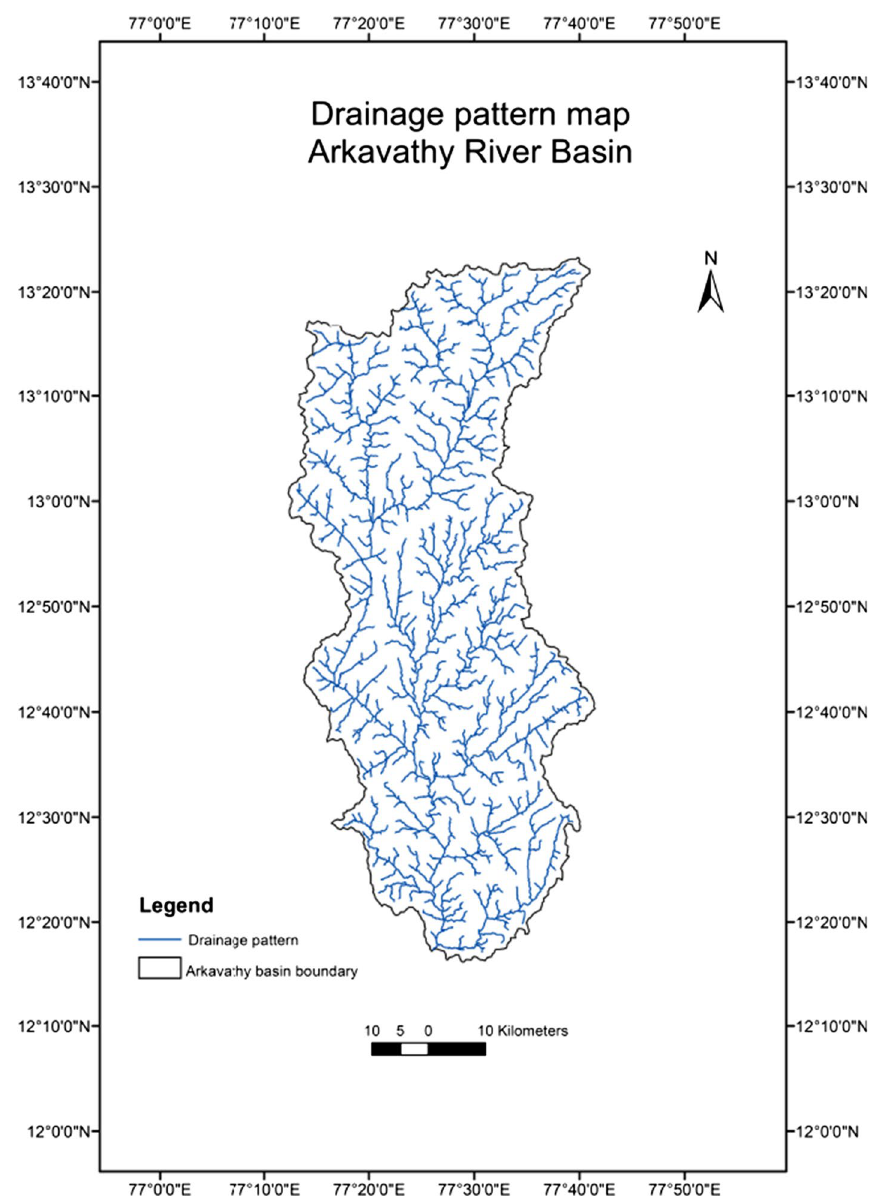
Fig. 7 Drainage pattern